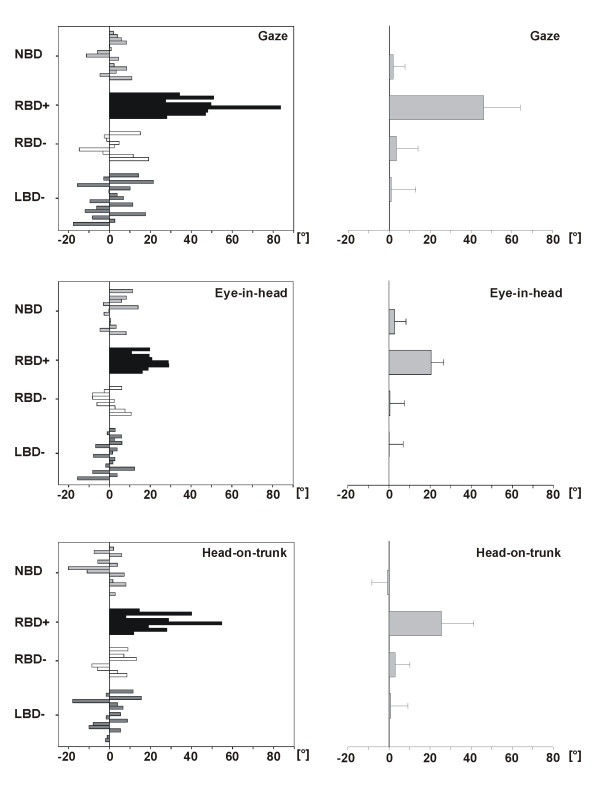
Left panel: Individual horizontal position (in degrees of visual angle) of gaze, eye-in-head, and head-on-trunk in all 48 subjects, each averaged over the 180s period of data acquisition. NBD, non brain-damaged healthy subjects (light grey bars); RBD+, right hemisphere stroke patients with spatial neglect (black bars); RBD-, right hemisphere stroke patients without spatial neglect (white bars); LBD- left hemisphere stroke patients without spatial neglect (dark grey bars). During the time period of the present investigation no patient with spatial neglect following left hemisphere stroke could be investigated. Right panel: Mean horizontal position (and standard deviation) of the different groups and variables.